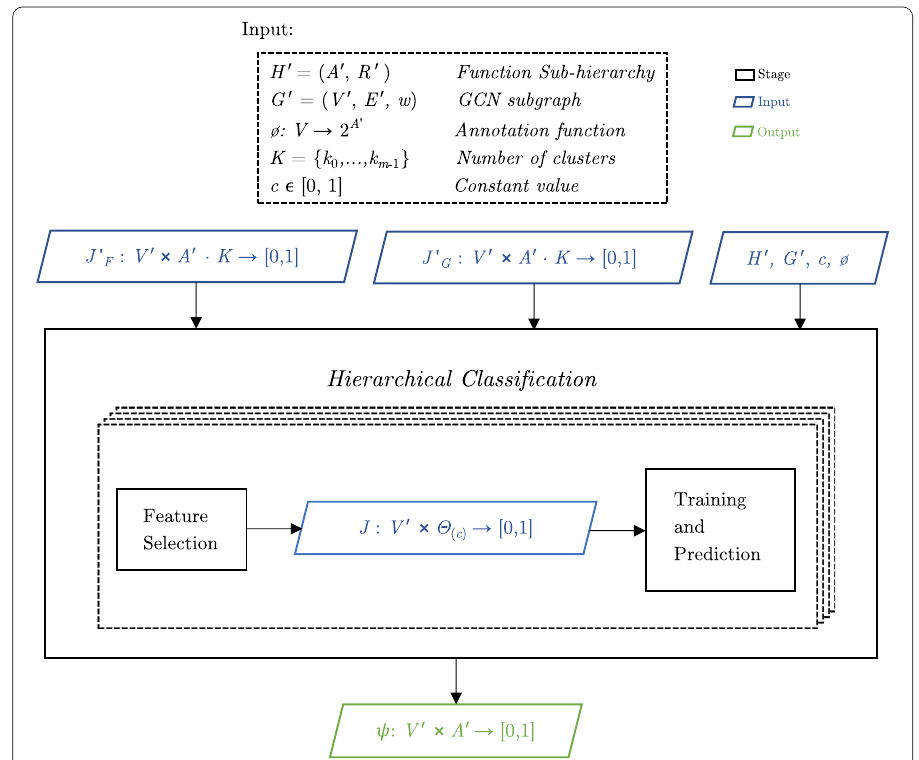
Fig. 3 The prediction approach mainly consists of two stages, feature selection with SHAP and hierarchical multi-label classification. Its inputs are a sub-hierarchy H ′ = ( A ′ , R ′ ) , a subgraph of the GCN G ′ = ( V ′ , E ′ , w ) , an annotation function φ : V → 2 A ′ that satisfy the sub-hierarchy H ′ , the sub-matrices of J G and J F